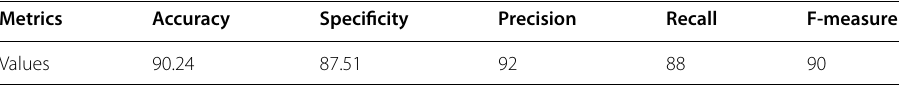
Table 6 Results of machine learning techniques on the Framingham dataset